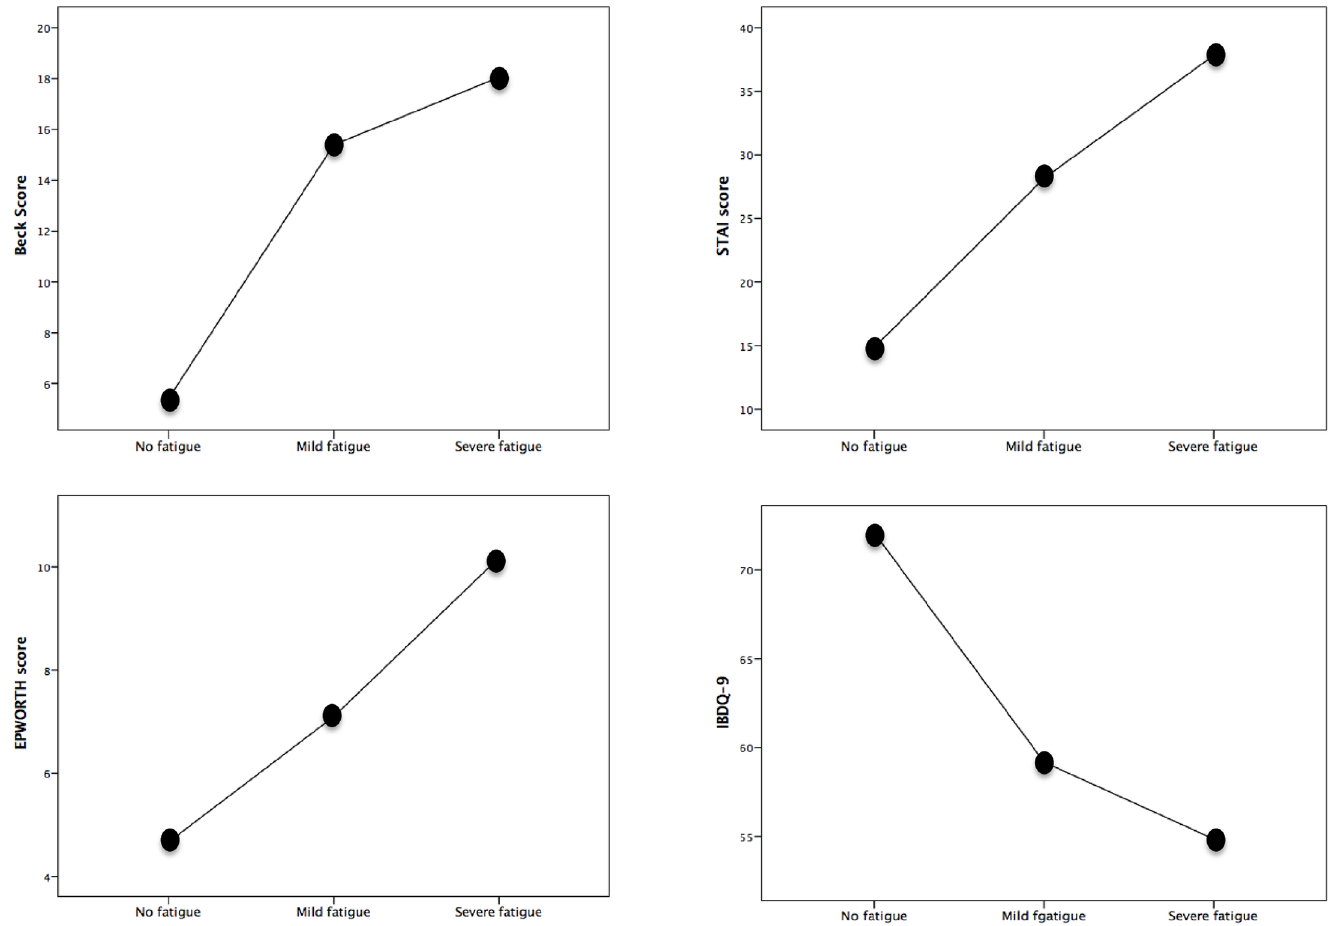
Fig 2. Relationship between psychological test and